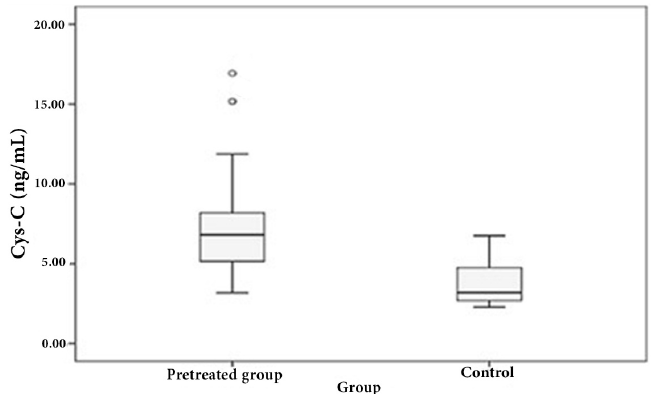
Figure 1. Box plot shows a comparison between the median cystatin C level (Cys-C) (ng/mL) and its range in pretreated patients versus healthy controls.